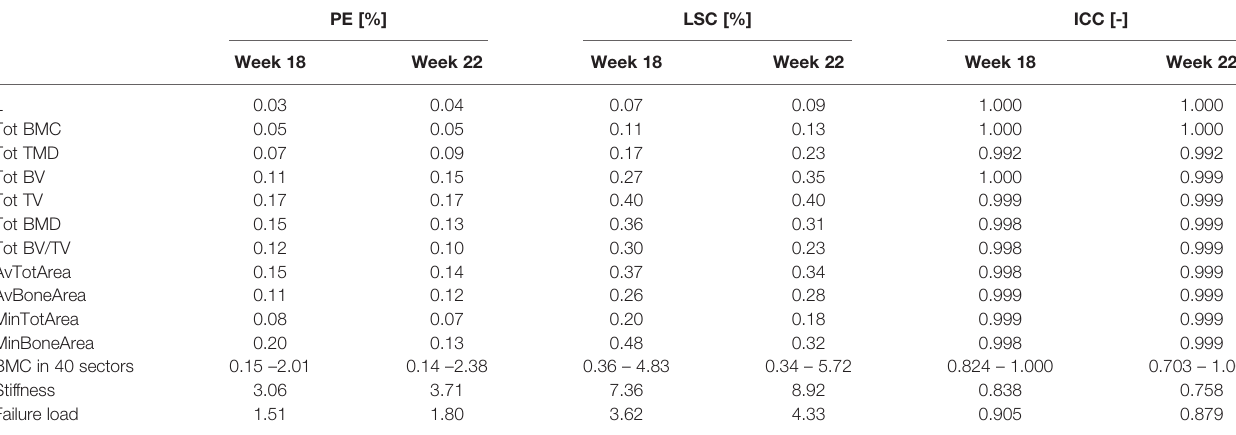
TABLE 2 | Intra-operator reproducibility of densitometric and mechanical parameters.